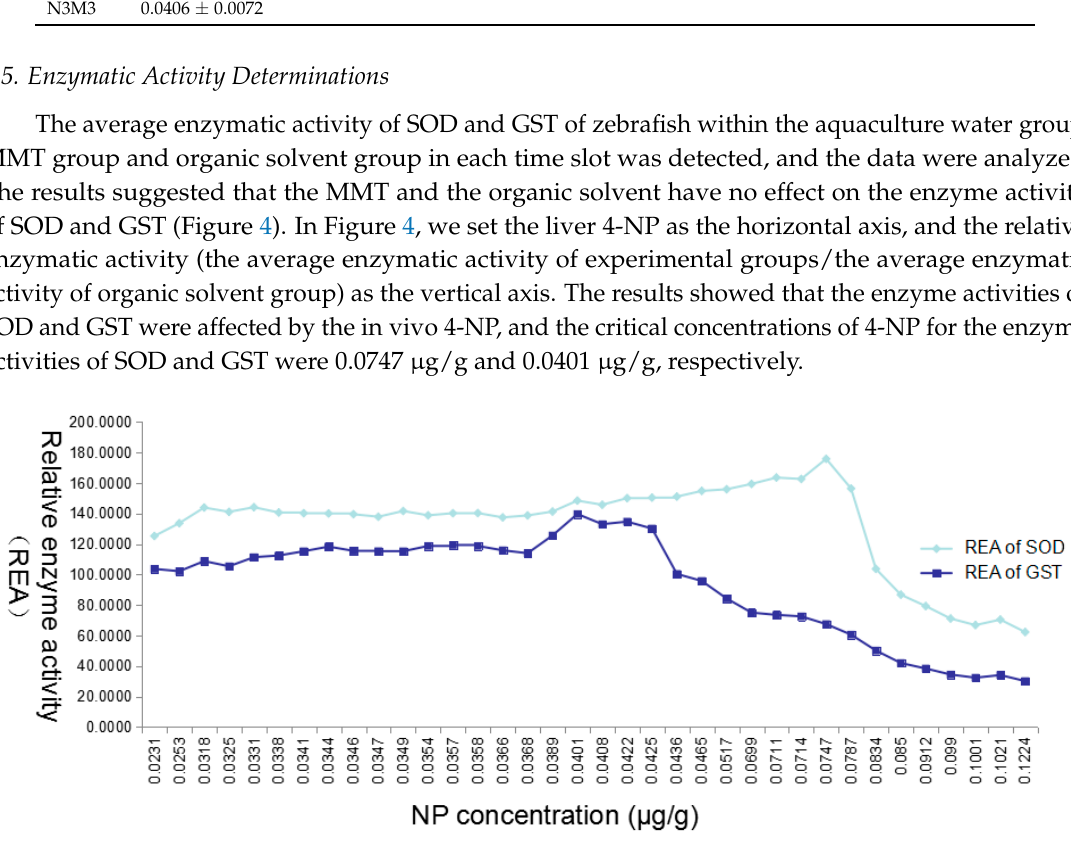
Figure 4. The relative enzyme activity (REA) of SOD and GST under the different 4-NP